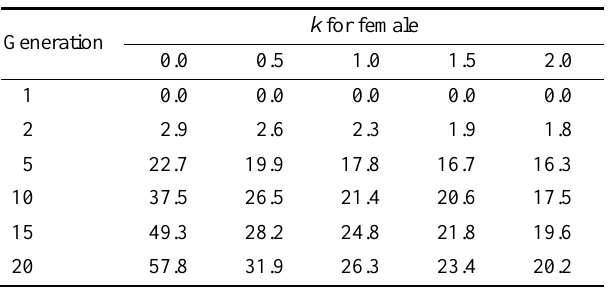
Table 3. Percent of increases in the rates of inbreeding compared to the case of k = 0.0 for male and female